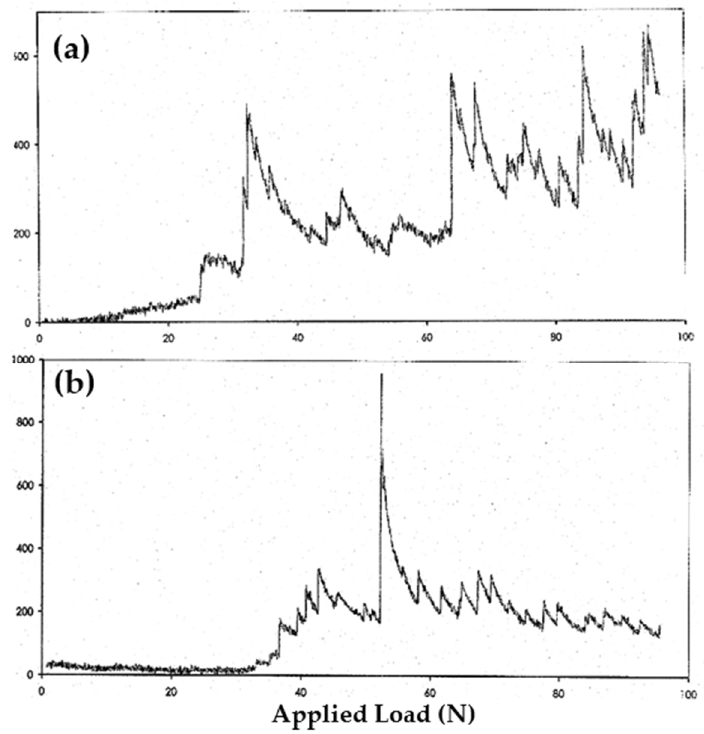
Figure 8. Acoustic emission graphs of ( a ) SH4 SIARL coated and ( b ) ULTRA 600 coated soda-lime glass specimens.